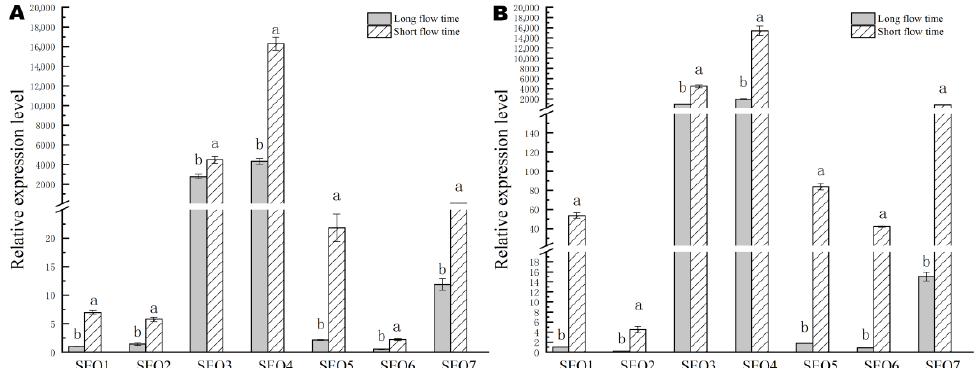
Figure 10. The relative expression of HbSEOs in the barks and latices of rubber trees with different flow durations. ( A ) in barks, ( B ) in latices. Data normalization was performed with the expression level of HbSEO1 in the long duration; ANOVA was performed for the same gene with different flow times. Different small-case letters signify statistical differences between means following Duncan’s one-way ANOVA ( p < 0.05) for same genes.